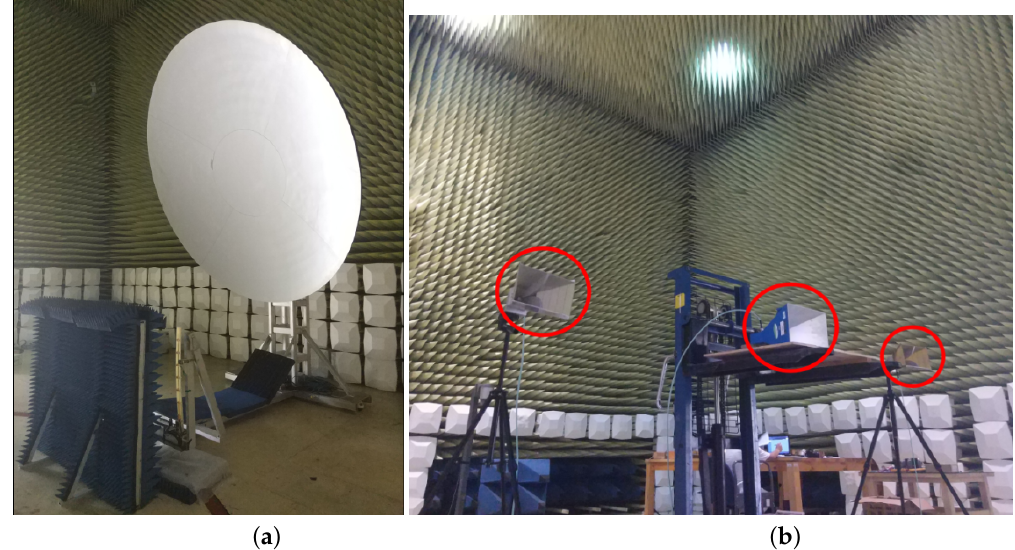
Figure 9. The off-axis parabolic reflector antenna with optical-electronic sensors ( a ) and horn antennas on the object plane ( b ).